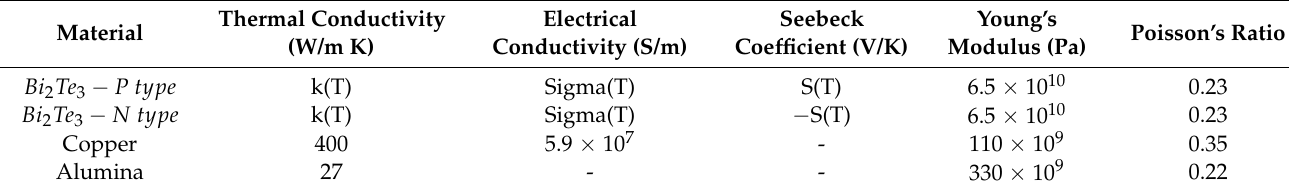
Table 1. TEG Material